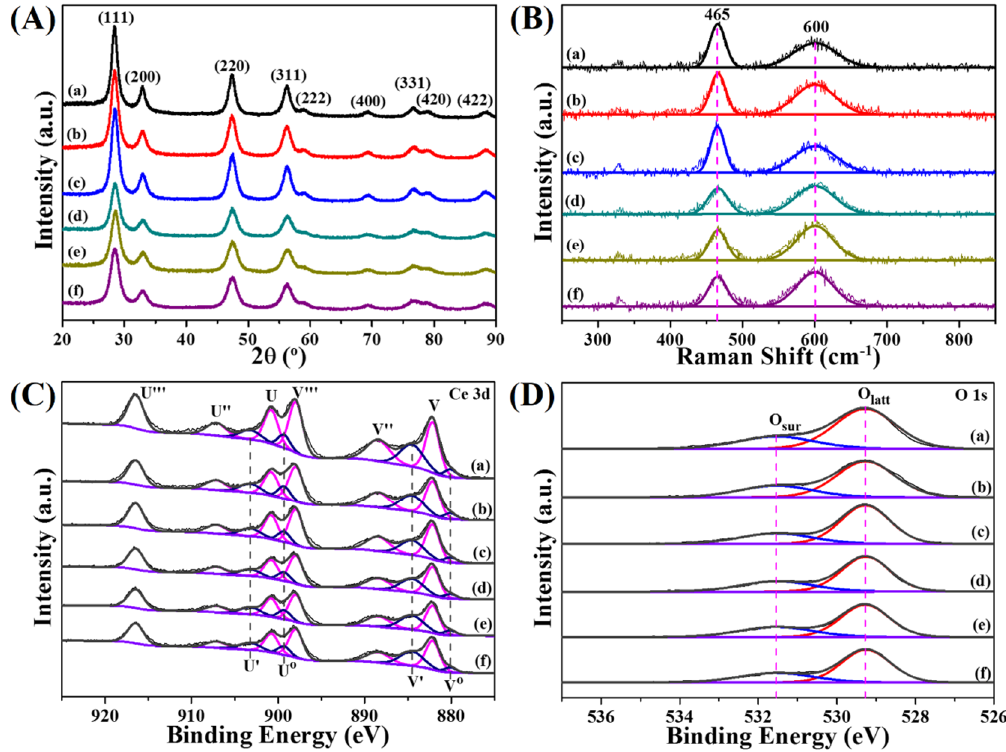
Figure 4. Crystal structure and surface chemical properties of various functional MOF derivatives.